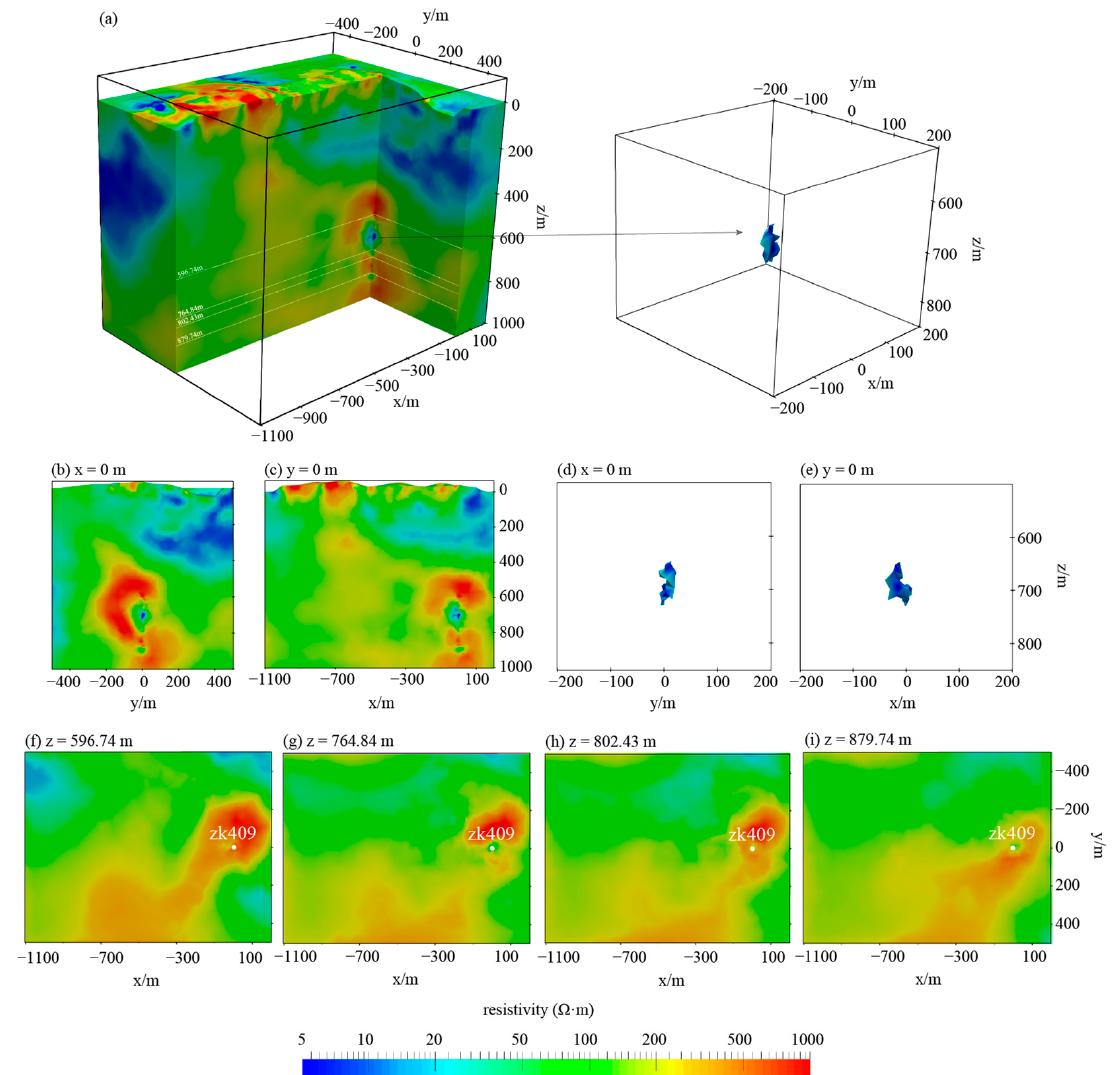
Figure 16. Dual-mesh inversions of the survey data from the Western Tonglu Mountain copper mine in Daye, China. ( a ) 3D resistivity distribution; ( b ) slice at x = 0 m; ( c ) slice at y = 0 m; ( d ) ore body in borehole at x = 0 m; ( e ) ore body in borehole at y = 0 m; ( f – i ) x , y slices at rock sample positions.